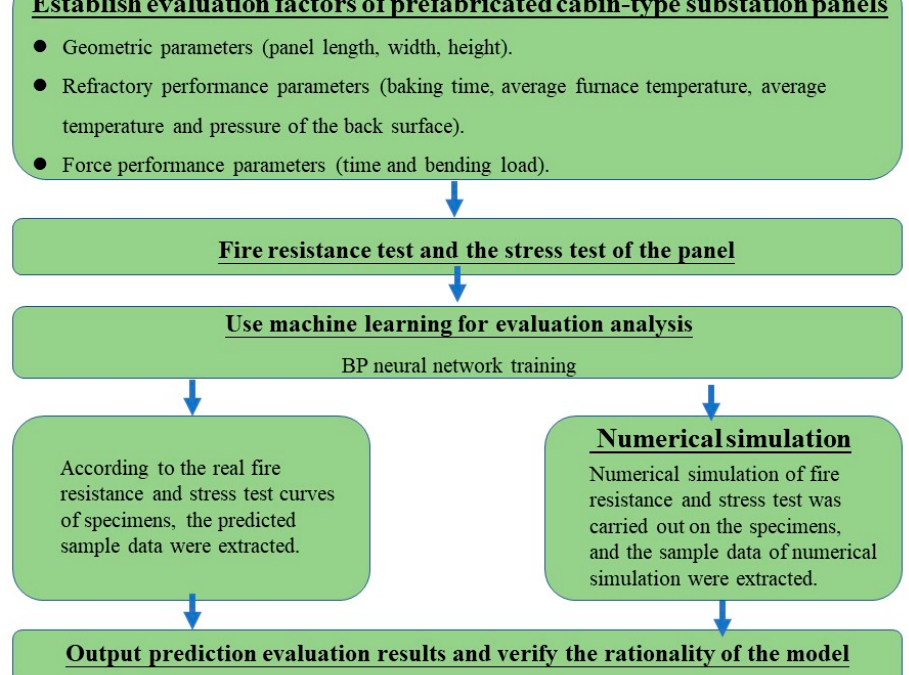
Figure 1. Research process of thermal–mechanical coupling evaluation of panel performance.